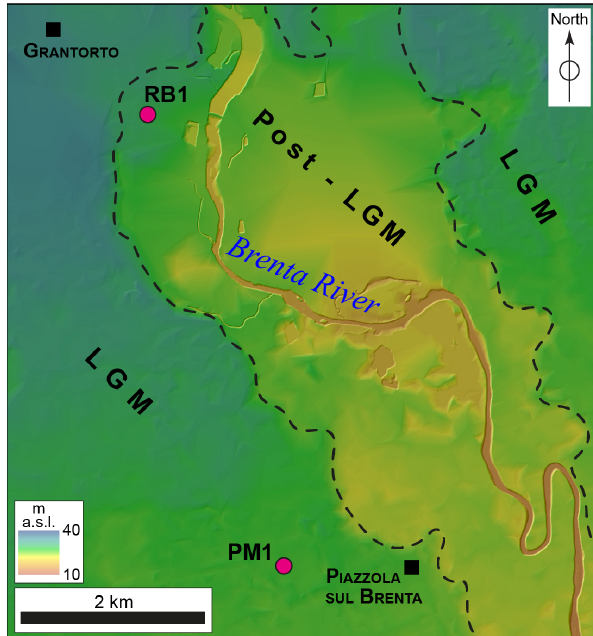
Figure 3. Location of the PM1 and RB1 cores (purple circles). The background is a 5m cell DTM (modified from data provided by Regione Veneto, 2011), stretched to highlight elevation changes. Scarps bounding the post-glacial incision of the Brenta megafan are denoted by black dashed